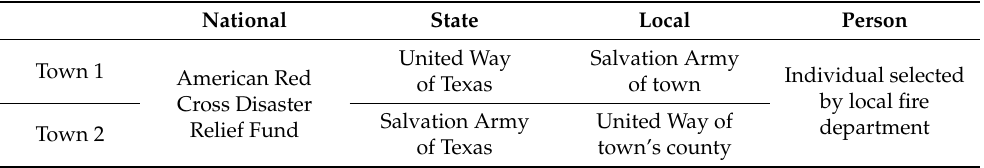
Figure 1. Decision sheets used by subjects when deciding allocations between themselves and charities in the comparative dictator game. References to towns are blacked out. Table 1. Recipient organizations in the comparative dictator game.